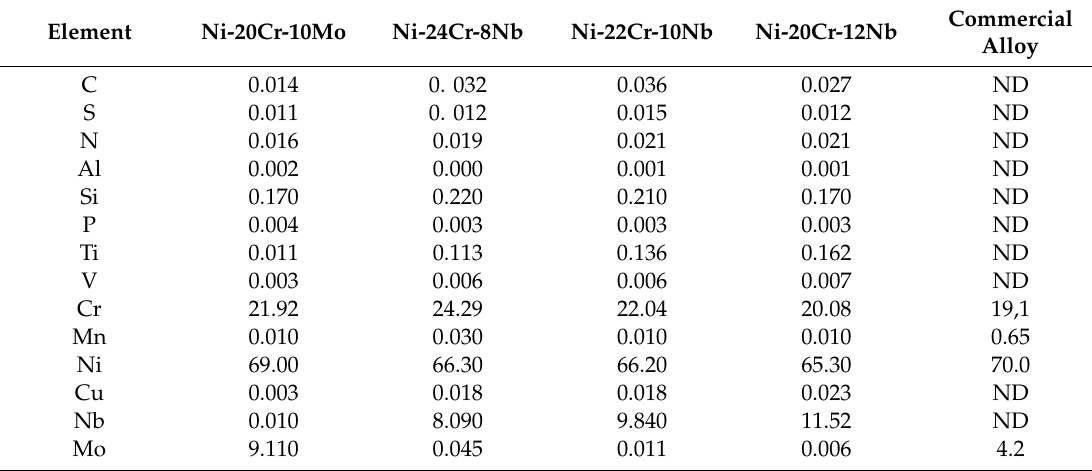
Table 1. Elemental contents (wt. %) measured by an ICP-AES analysis of the Ni-Cr-Nb and Ni-Cr-Mo alloys evaluated in this